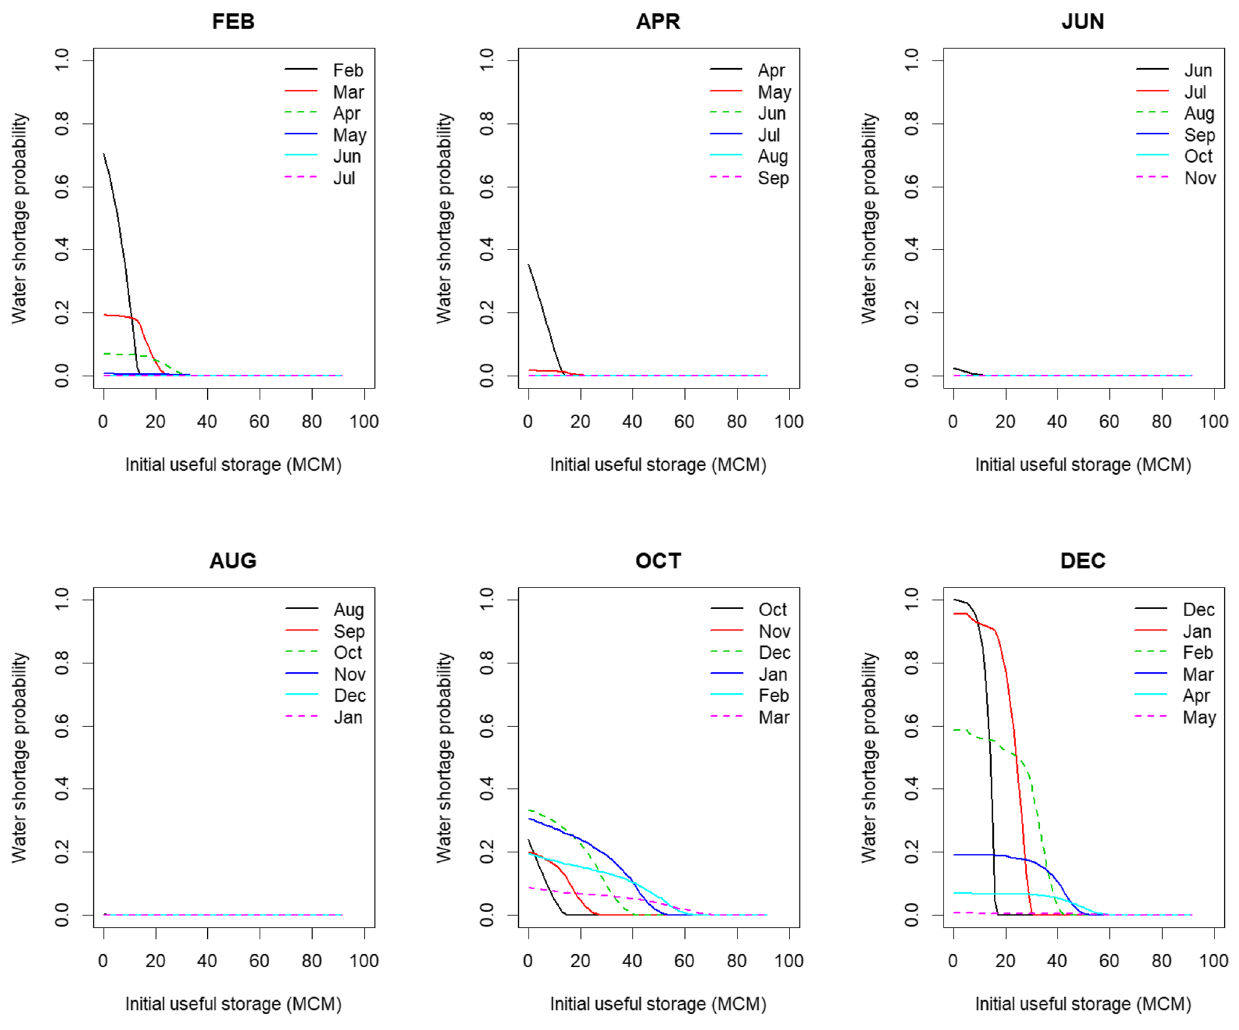
Fig. 4 The estimated water shortage probabilities conditioned on initial useful storages for 1- to 6-month lead times in various calendar